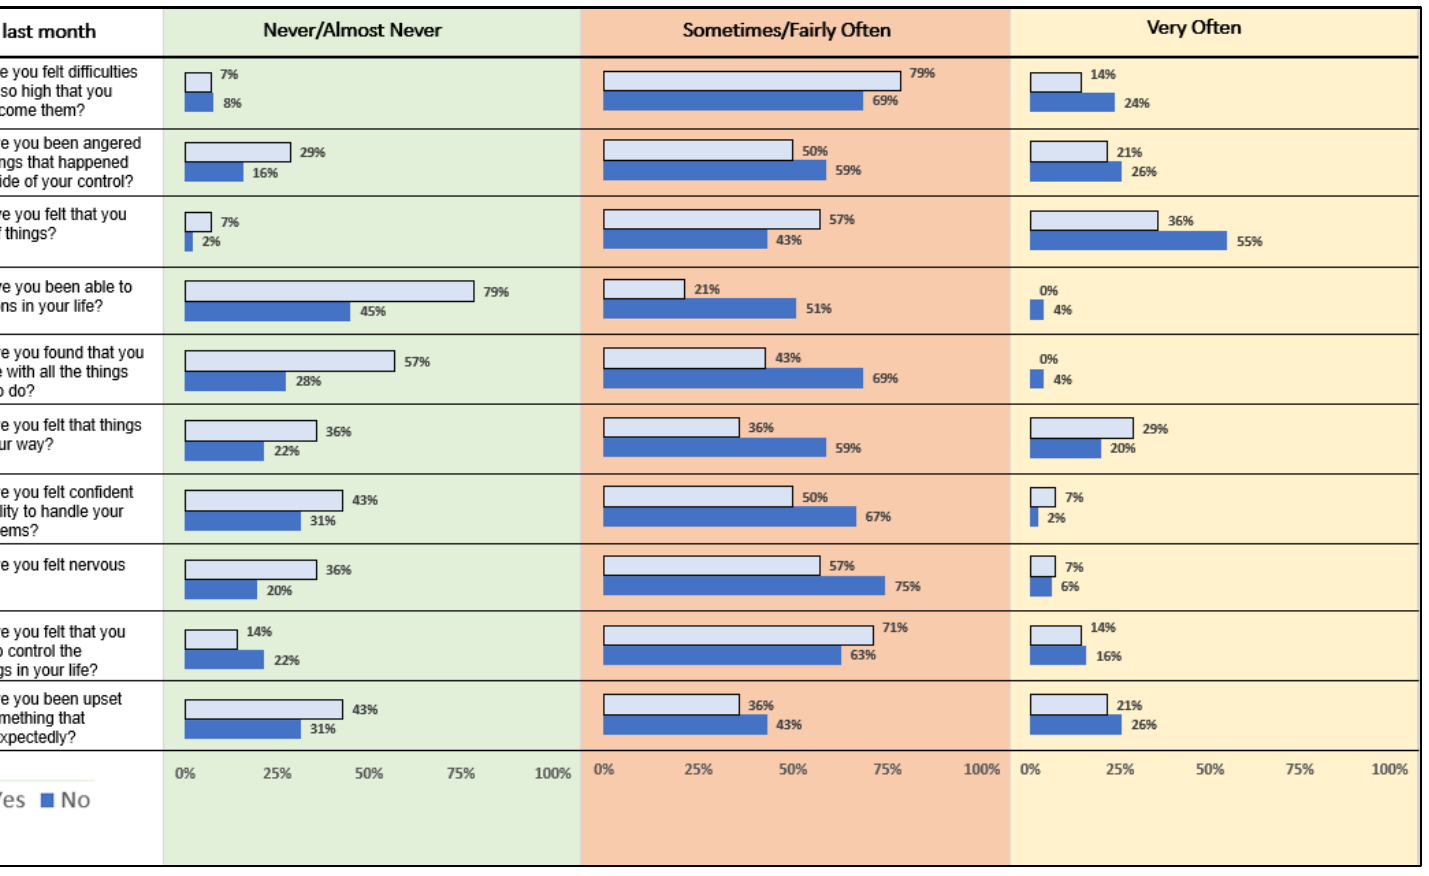
Figure 2. Item-wise analysis of perceived stress reported by college students engaged or not engaged in introspective meditation. Figure legend: Yes, corresponds to students engaged in the introspective meditation; No, corresponds to the students who were not engaged in the introspective meditation.